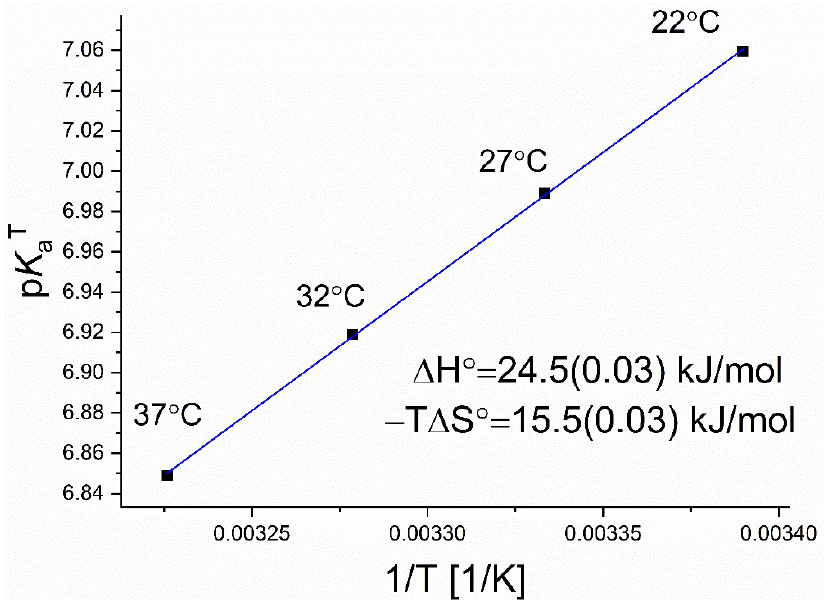
Figure 5. The dependence of the p K T a values obtained using the MST method on the inverse absolute